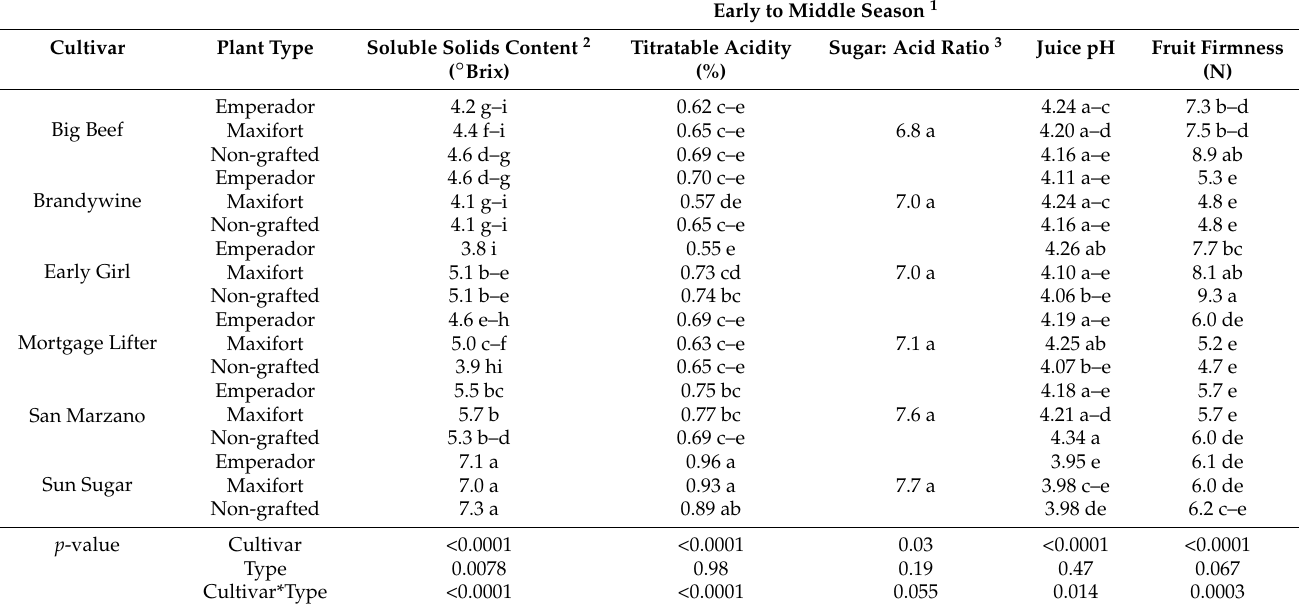
Table 4. Fruit quality variables in six tomato cultivars when grafted onto two types of rootstocks or grown non-grafted in a high tunnel during early to middle season.